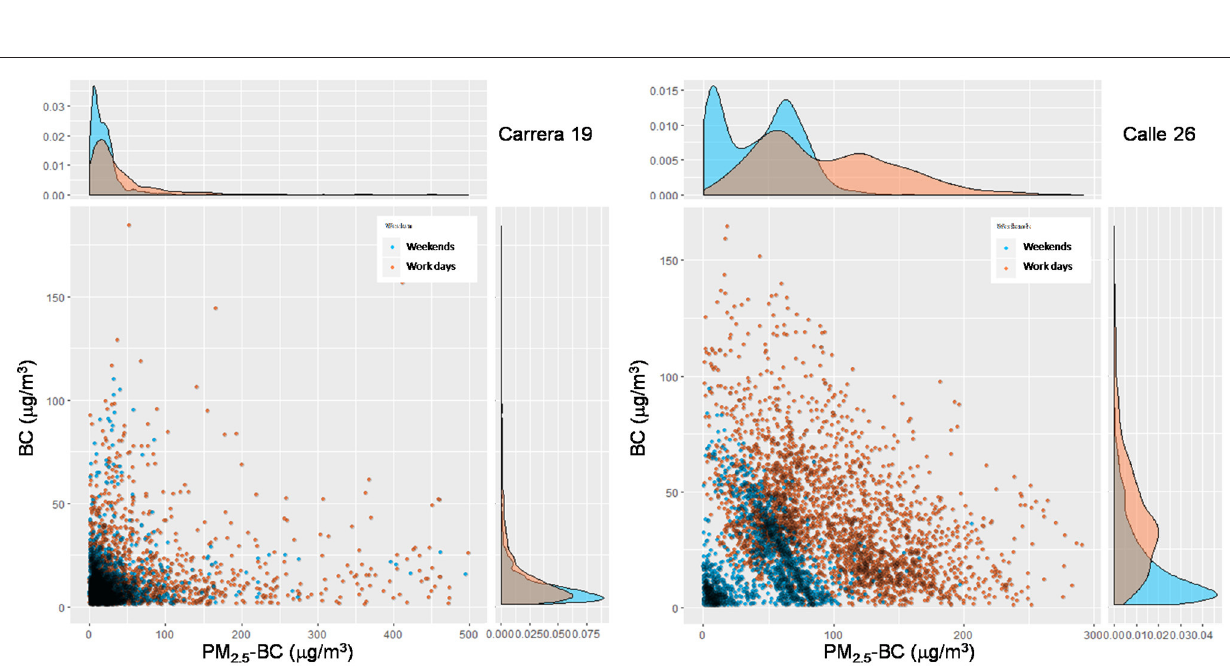
Frontiers in Environmental Science |